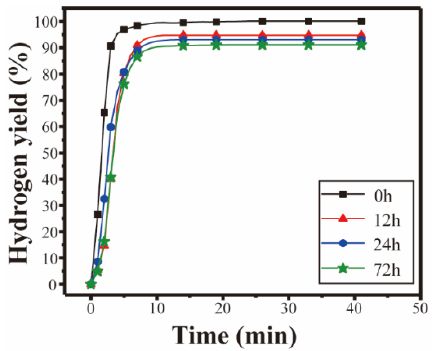
16 of 19 Figure 10. Surface morphologies of the Al-10Bi-7Sn-xFe (x = 0, 1.5) (wt.%) composite powders ex- posed to air for different times (25 °C and 60 RH%): ( a ) Al-10Bi-7Sn-1.5Fe (wt.%), 12 h; ( b ) Al-10Bi- 7Sn-1.5Fe (wt.%), 24 h; ( c ) Al-10Bi-7Sn-1.5Fe (wt.%), 72 h; ( d ) Al-10Bi-7Sn (wt.%), 12 h [33]. The hydrogen generation properties of the composite powders after storing for dif- ferent hours while reacting with CaCl 2 solution were investigated, and the results are shown in Figure 11. As shown in Figure 11, after 12 h of exposure, the hydrogen yield of the Al-10Bi-7Sn-1.5Fe (wt.%) powders was 94.7% when they reacted with 0.1mol·L −1 CaCl 2 solution, which was 5% lower than that of the powders not exposed to air. With exposure time prolonged to 24 and 72 h, the hydrogen yield decreased to 93% and 91%. These re-